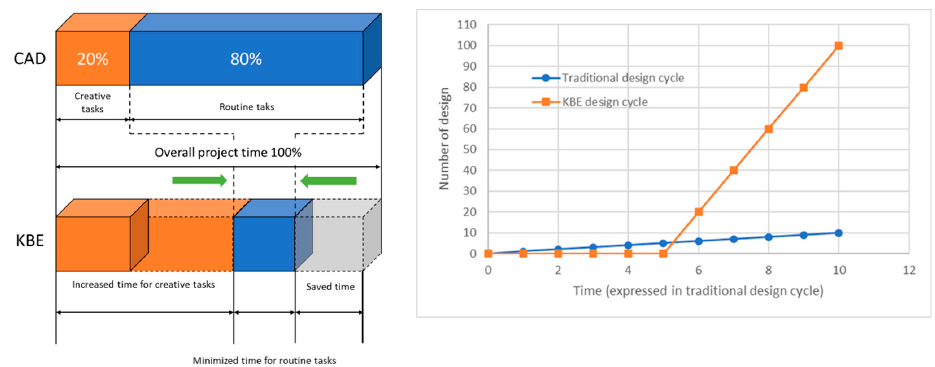
Figure 4. Benefits of the knowledge-based engineering (KBE) approach [10]. Copyright 2007 Elsevier.